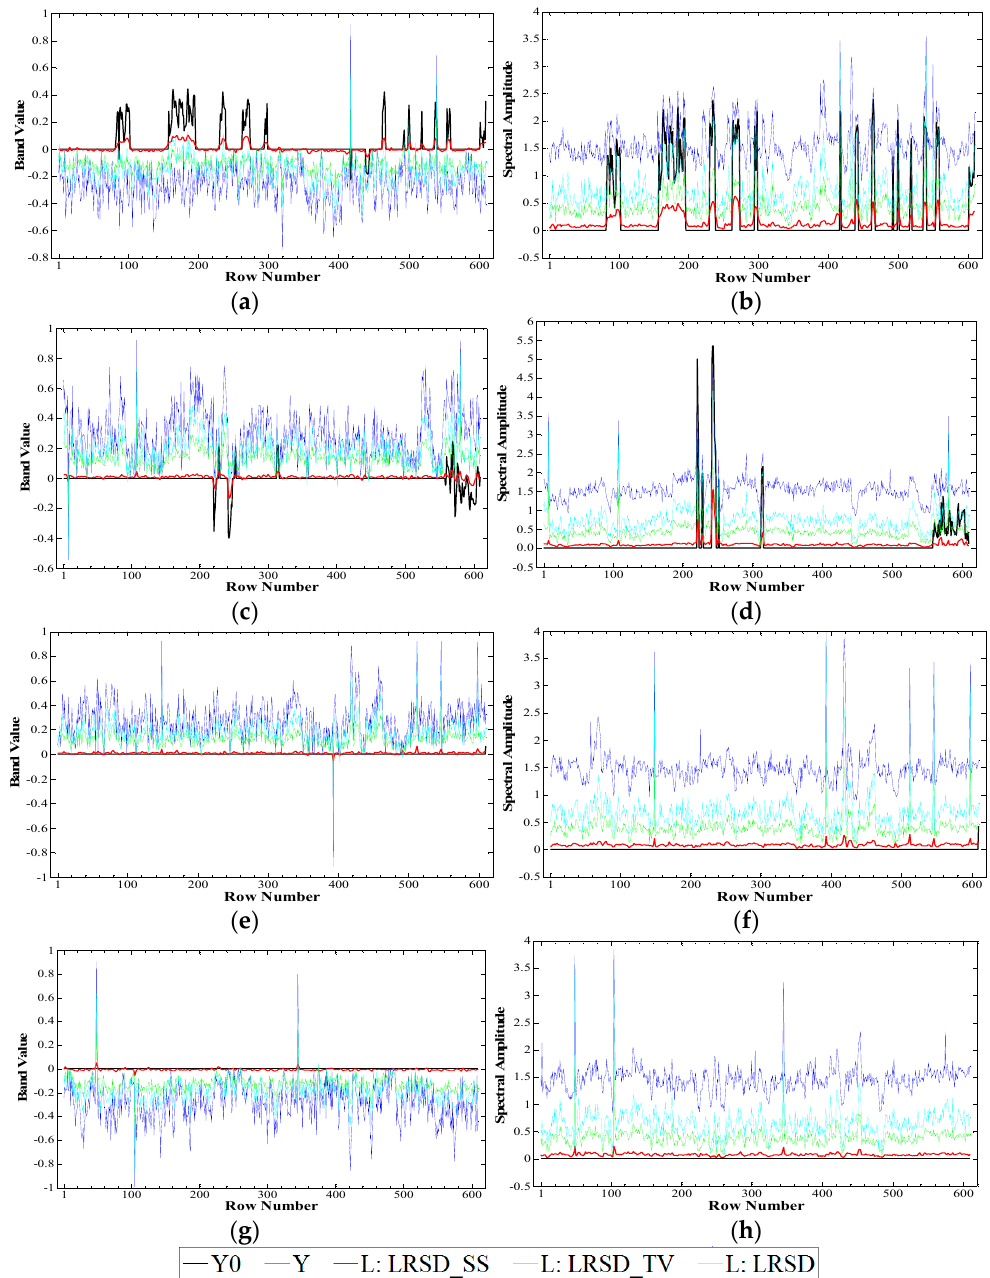
Figure 8. In an exemplary case of Data 10: ( a ) spectral signatures and ( b ) amplitudes of the samples at column 84; ( c ) spectral signatures and ( d ) amplitudes of the samples at column 170; ( e ) spectral signatures and ( f ) amplitudes of the samples at column 286; and ( g ) spectral signatures and ( h ) amplitudes of the samples at column 299 in Y , Y 0 and L produced by LRSD_TV/LRSD_SS/LRSD. All the samples at these locations in Y are corrupted by all the types of simulated noise.